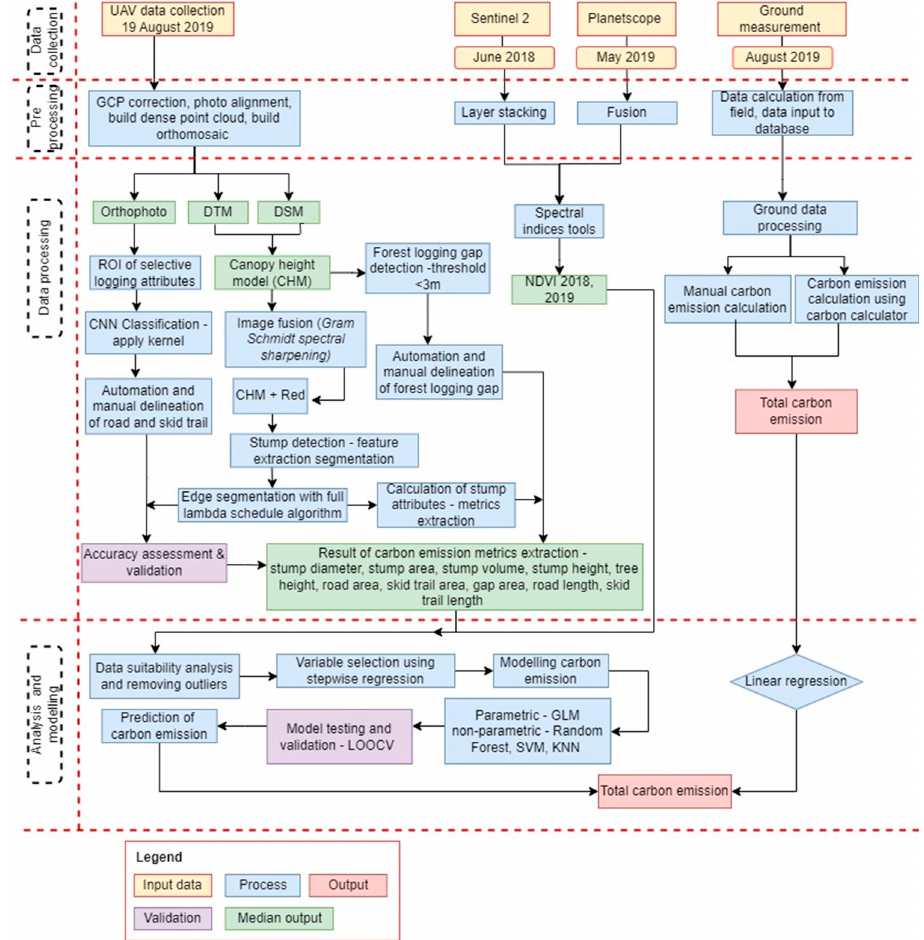
Figure 2. Overall workflow of the methodology.